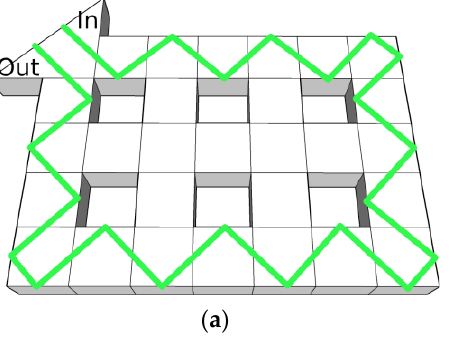
Figure 2. ( a ) The beam trajectory inside a smooth TPhTI model. ( b ) The corrected trajectory inside the TPhTI without prism resonator #3, as denoted in ( b ). The model shows that the light beam suc- cessfully bends around the defect of TPhTI. successfully bends around the defect of